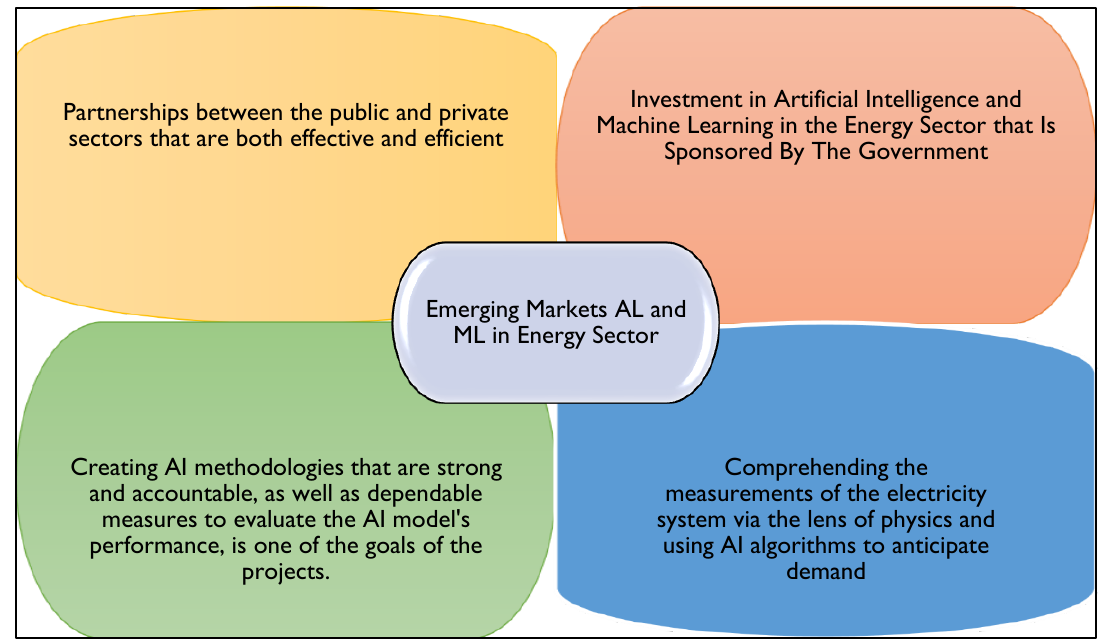
Figure 7. Proposals for AI and ML to be effective for emerging markets.